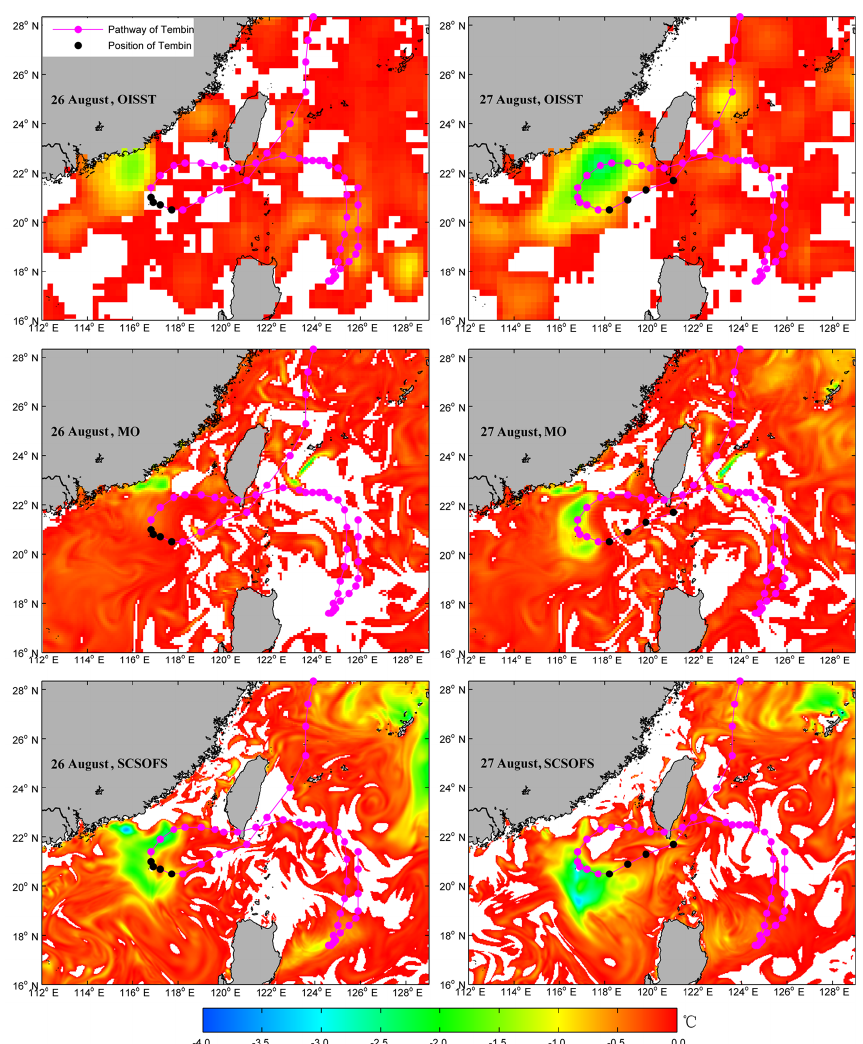
Figure 11. The SST differences of the day from the last day during the period of Typhoon Tembin. The black dots are the positions of the Typhoon Tembin at 00:00, 06:00, 12:00, and 18:00UTC on each day.